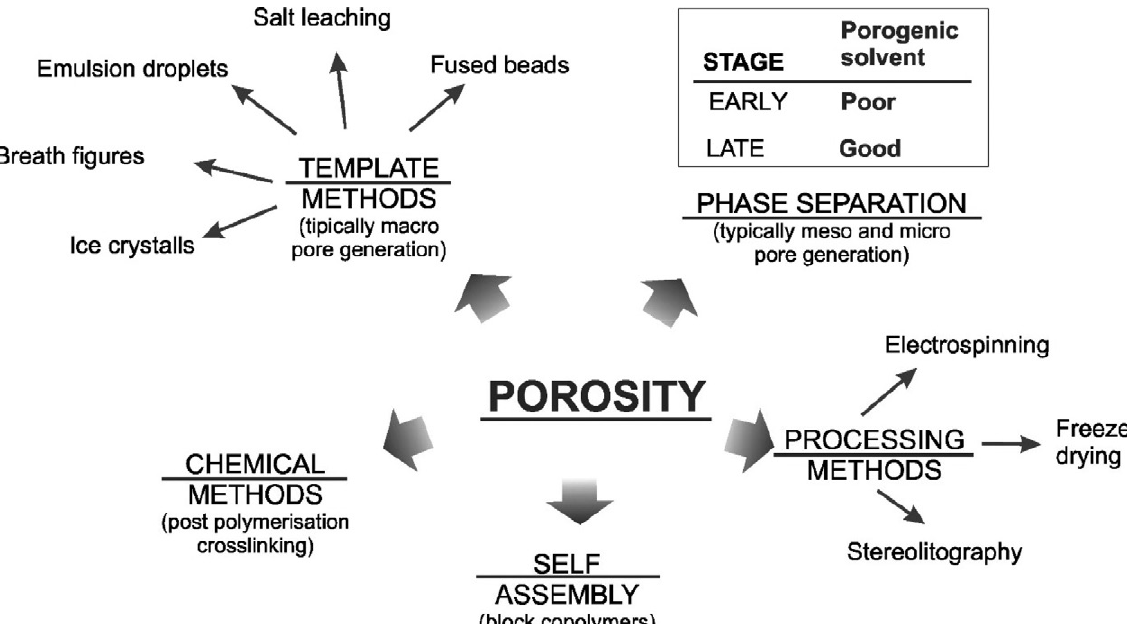
Figure 1 : Methods for porosity creation in polymers